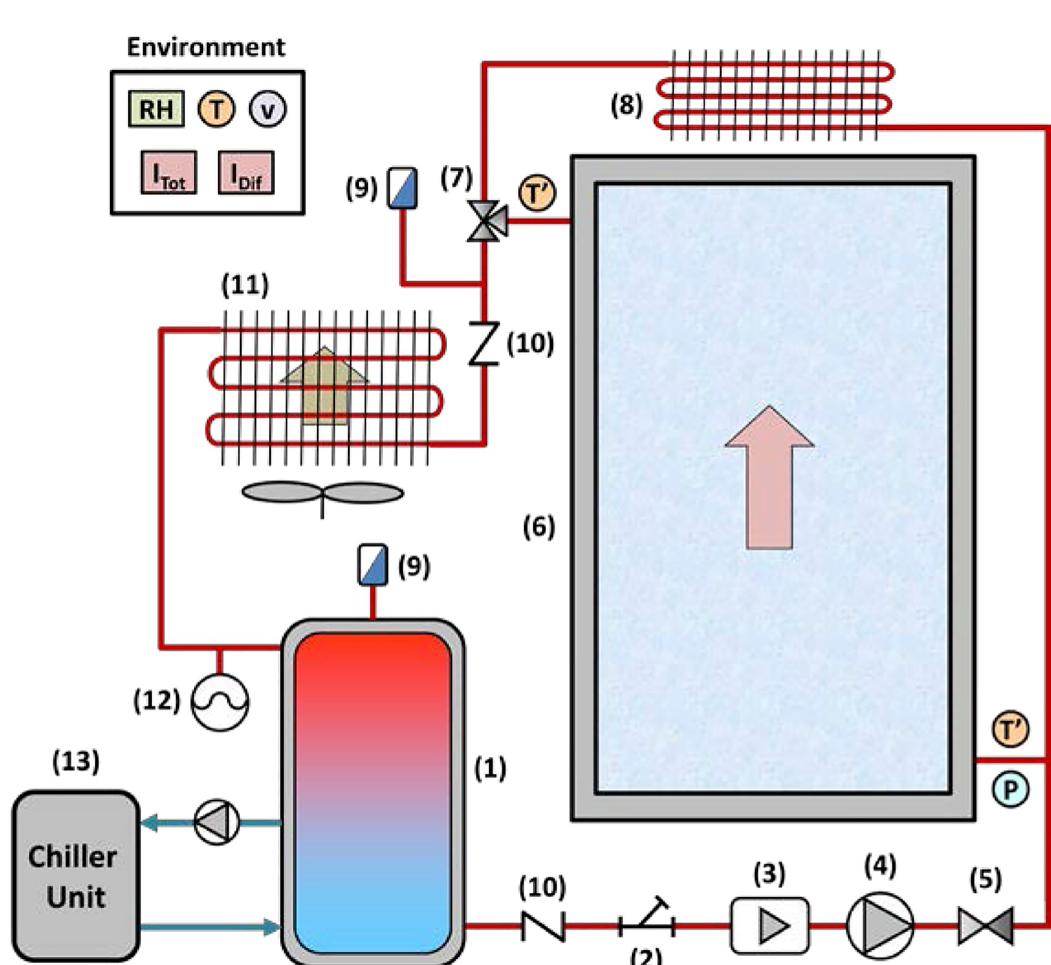
Fig 2. Diagram of the experimental set-up: (1) Accumulator tank; (2) filter; (3) magnetic flowmeter; (4) recirculating pump; (5) metering valve; (6) solar collector; (7) thermostatic valve; (8) passive air cross-flow heat exchanger; (9) steam trap; (10) check valves; (11) heat exchanger; (12) expansion vessel; (13)